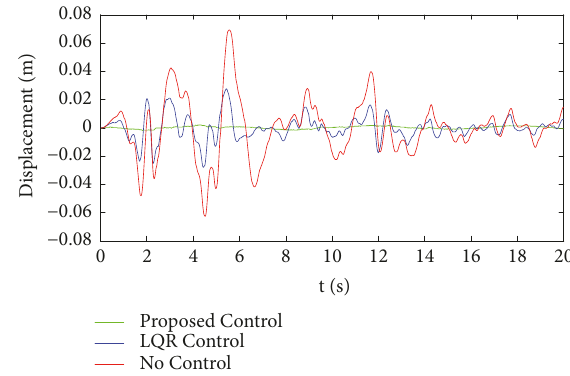
Figure 1: Displacement response of Example 1.